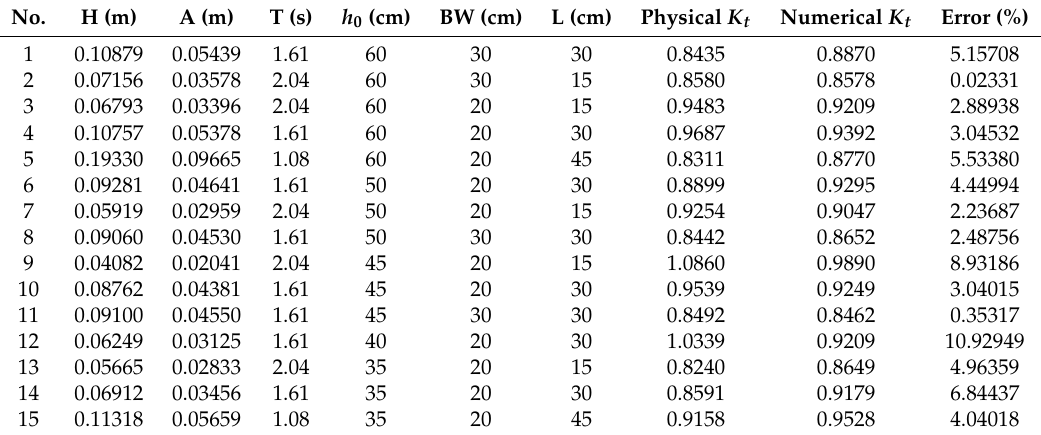
Table 4. Comparison between physical and numerical K t for various model